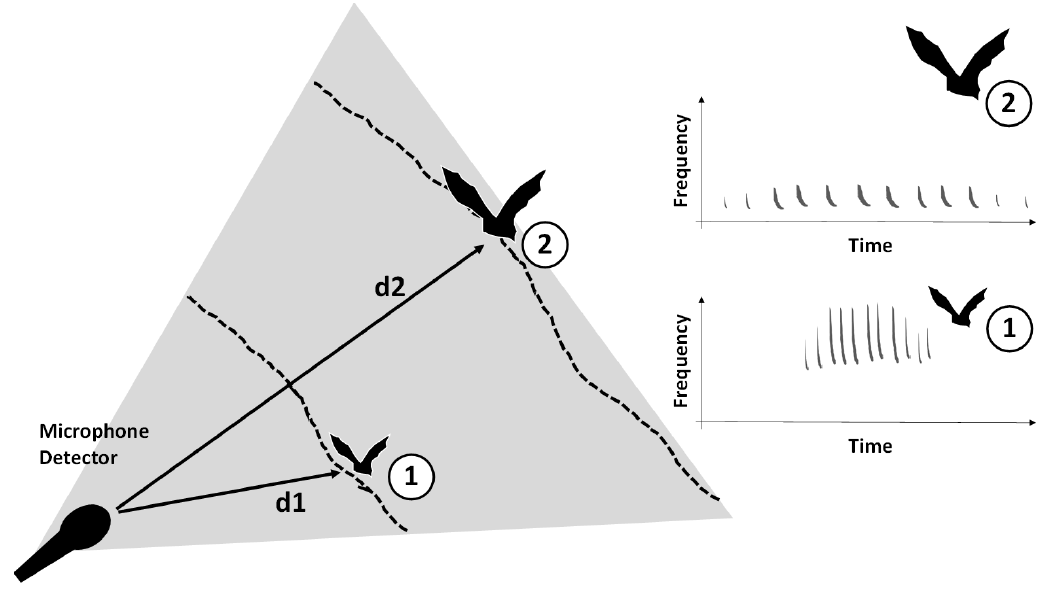
Figure 2. Link between bat trajectory and recording bat-passes for two species with different maximal distances of detection (d1, e.g., a Myotis spp. ) . and (d2, e.g., a Nyctalus spp.).